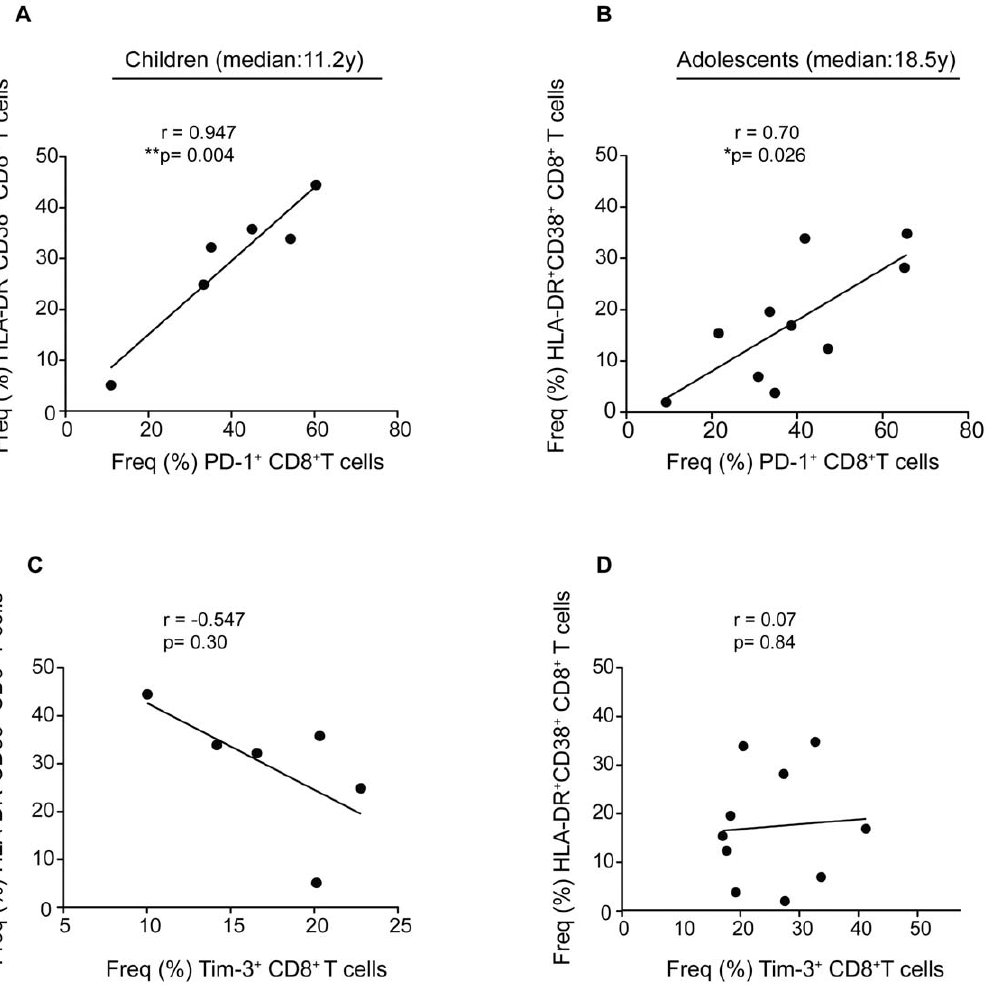
Figure 5. PD-1 + CD8 + T cells have a strong significant correlation with immune activation in both age groups. Scatter plots showing a correlation between immune activation and PD-1 + or Tim3 + CD8 + T cells. (A) and (B) show a significant strong correlation between HLA- DR + CD38 + CD8 + T cell and PD-1 + CD8 + T cells in children with shorter duration of HIV-1 infection (Spearman r=0.947, **p=0.004) and adolescents with longer duration of HIV-1 infection (Spearman r=0.70, *p=0.026) respectively. (C) and (D) show a correlation between HLA-DR + CD38 + CD8 + T cells and Tim-3 + CD8 + T cells in both age groups.